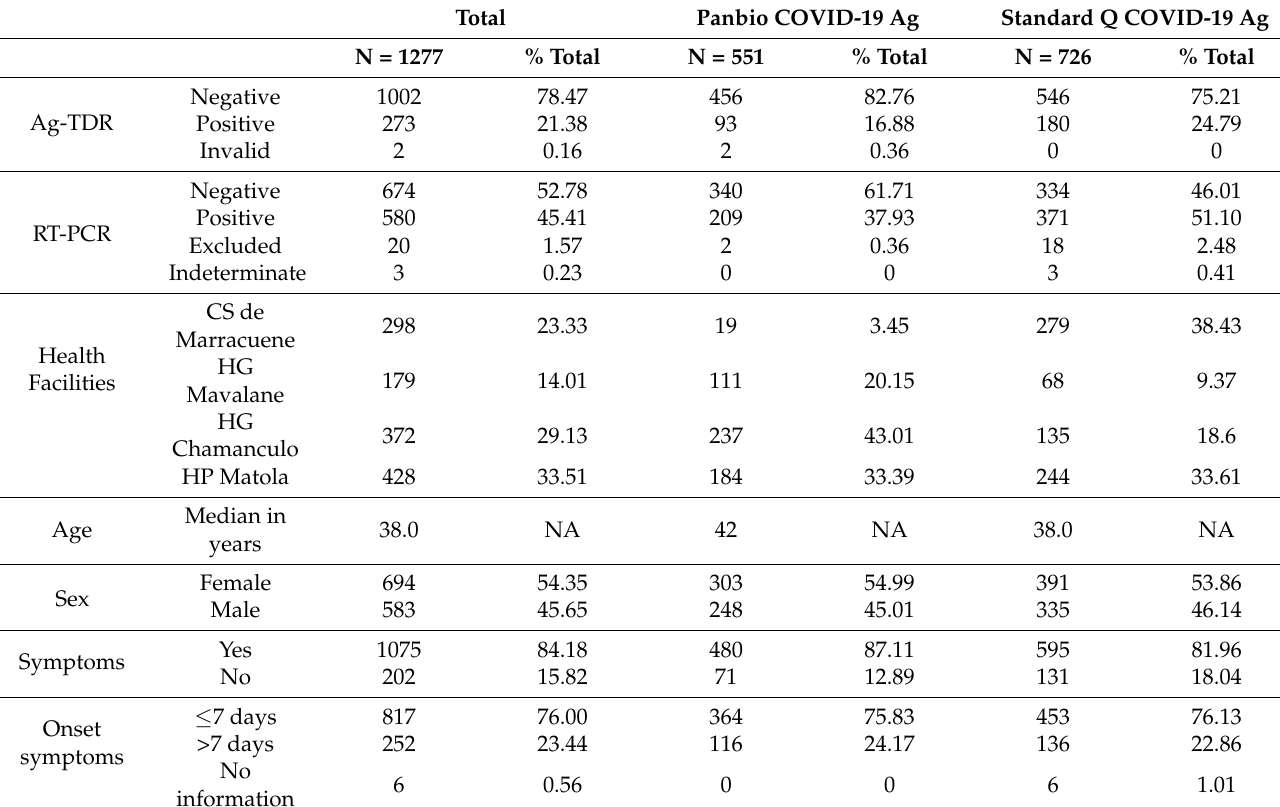
Table 1. Characteristics of study